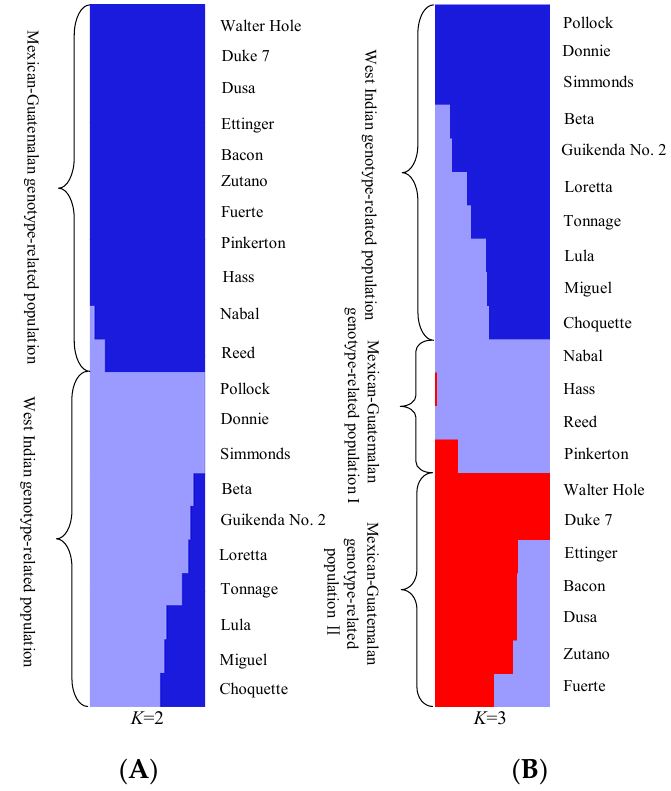
Figure 3. Population structure of avocado. ( A ) Population structure analysis of 21 avocado accessions under (the predicted optimal) number of populations ( K = 2) based on 34,704 SNPs from SLAF-seq using STRUCTURE; each individual is represented by a vertical bar. ( B ) Population structure analysis of 21 avocado accessions at K = 3 based on 34,704 SNPs from SLAF-seq using STRUCTURE; each bar represents a single individual: blue, West Indian; purple, Guatemalan; and red, Mexican.